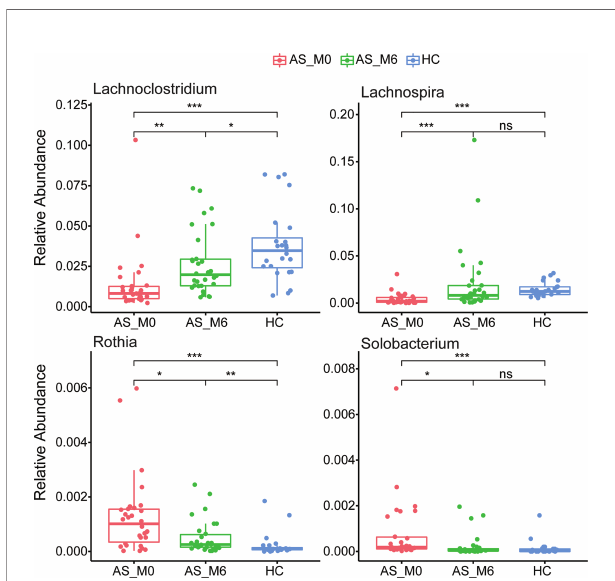
FIGURE 3 | Differential relative abundance of genera in AS patients before and after treatment. AS, ankylosing spondylitis. The horizontal bar within each box represents the median. The bottom and top of each box represent the 25 th and 75 th percentiles, respectively. The upper and lower whiskers extend to data no more than 1.5 × the IQR from the upper and lower edges of the box, respectively. * P < 0.05, ** P < 0.01, *** P < 0.001, ns, P > 0.05.